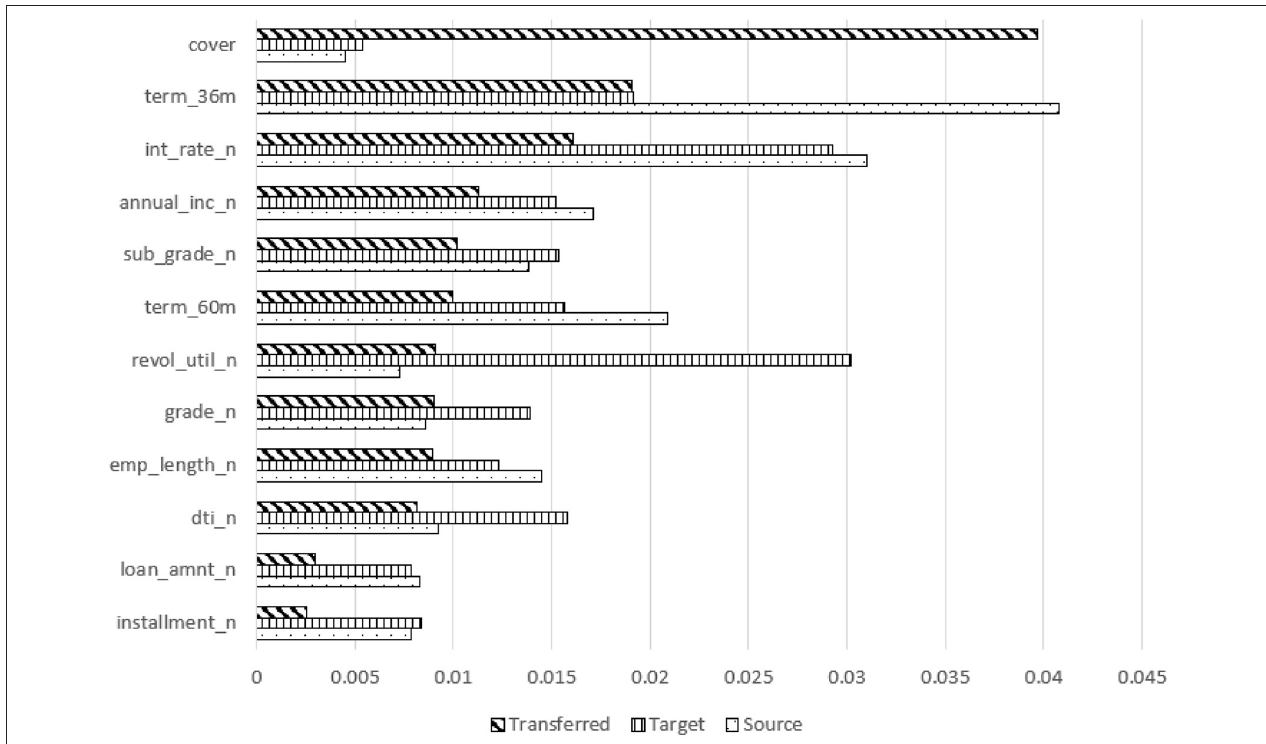
FIGURE 6 | Feature contribution comparison for transferred, target, and source models using SHAP-transferring from CD to MD.